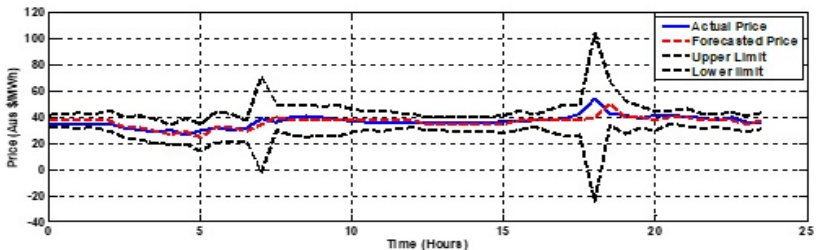
Figure 15. Winter weekdays plot of Tuesday (7 July 2015) without selected features with a MAPE of 6.88.